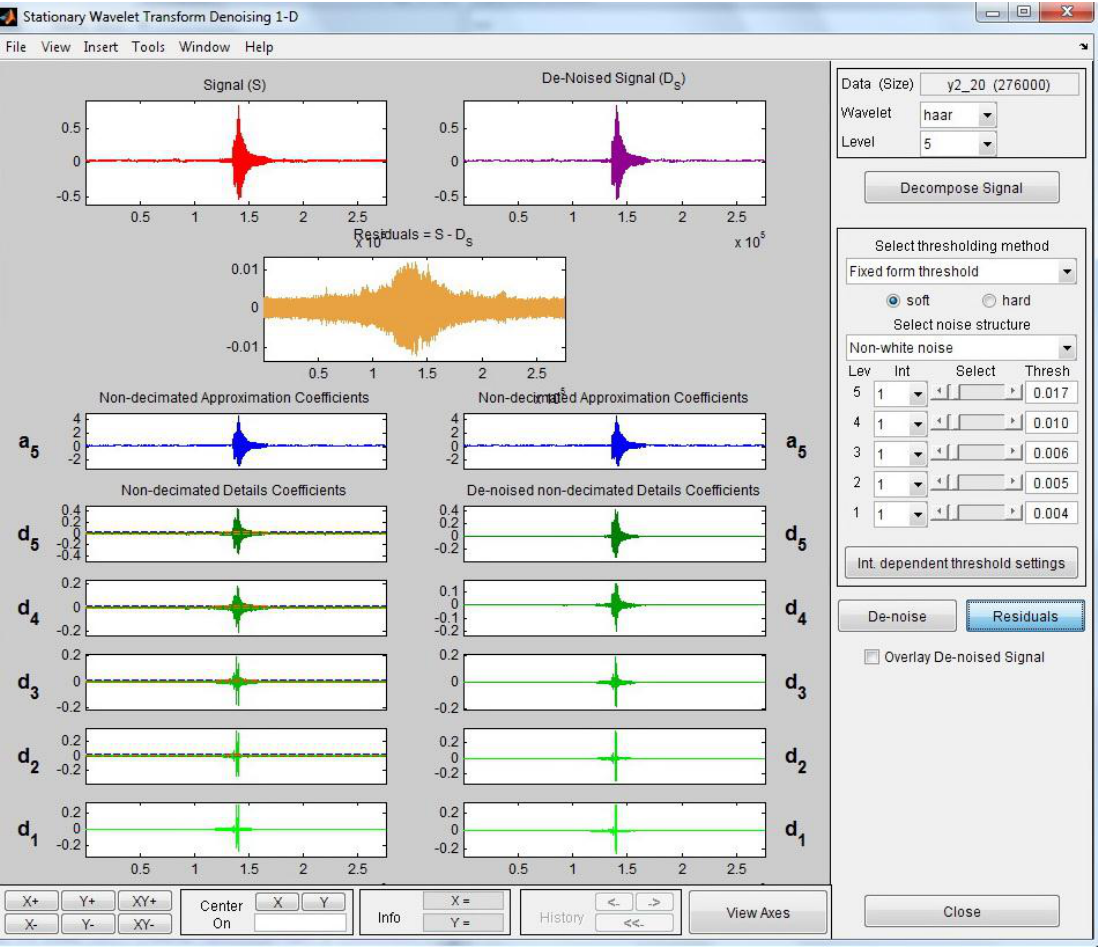
Fig. 27. The filtering of the acceleration signal experimentally